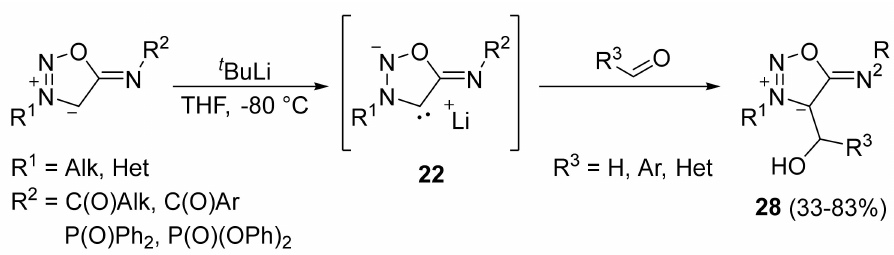
Scheme 17. Interaction of sydnone imine carbenoids with aldehydes.